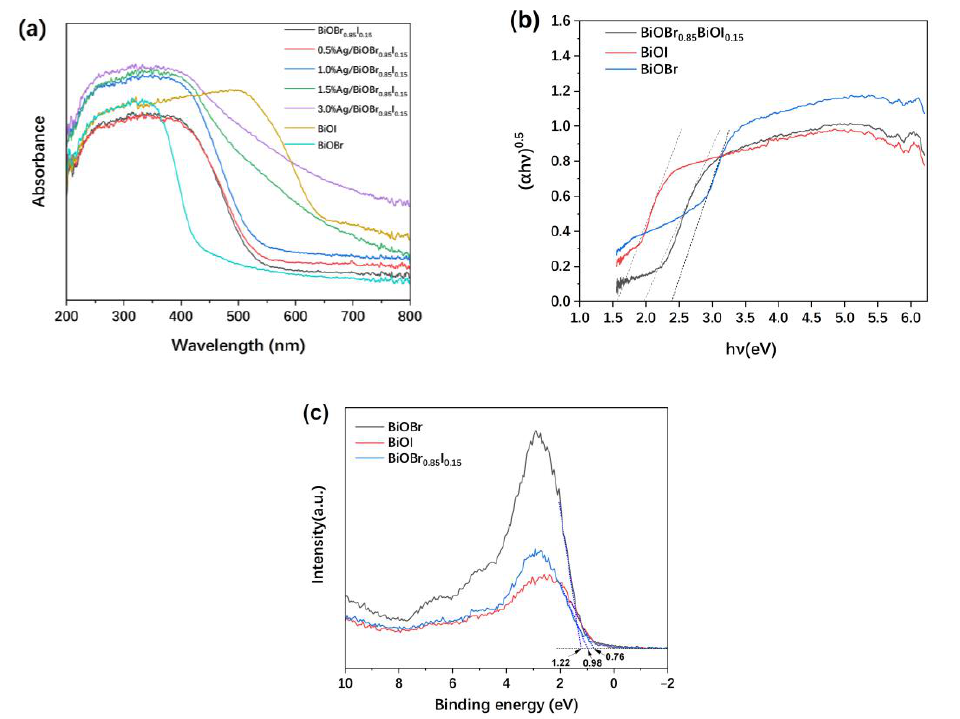
Figure 7. UV-vis diffuse reflectance spectra ( a ); the bandgap value, estimated by a related curve of (αh ν ) 0.5 versus photon energy ( b ); and the VB-XPS spectra of BiOBr, BiOI, and BiOBr 0.85 I 0.15 ( c